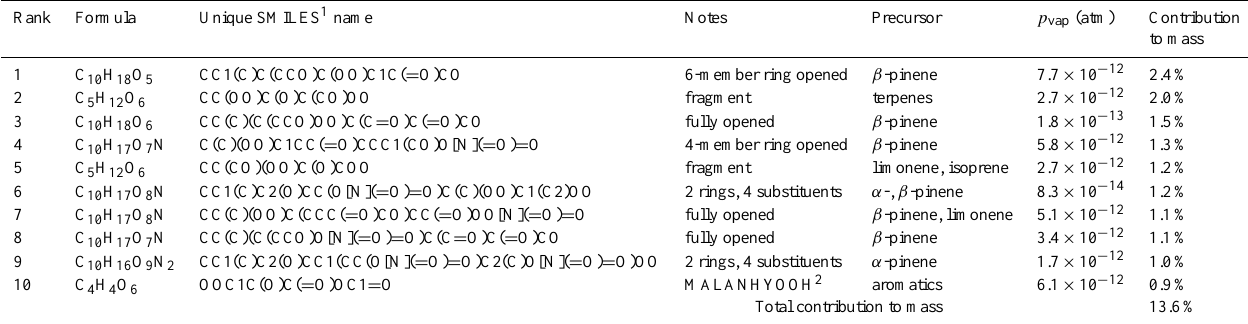
Figure 7. Hourly production rates of all species in the urban case particle phase, aggregated by broad chemical characteristics. (a) Cyclic products of aromatic precursors; (b) all other species. Colors show species groupings. See text for details. Table 4. The top 10 contributors to modeled particle mass at the end of the forest outflow